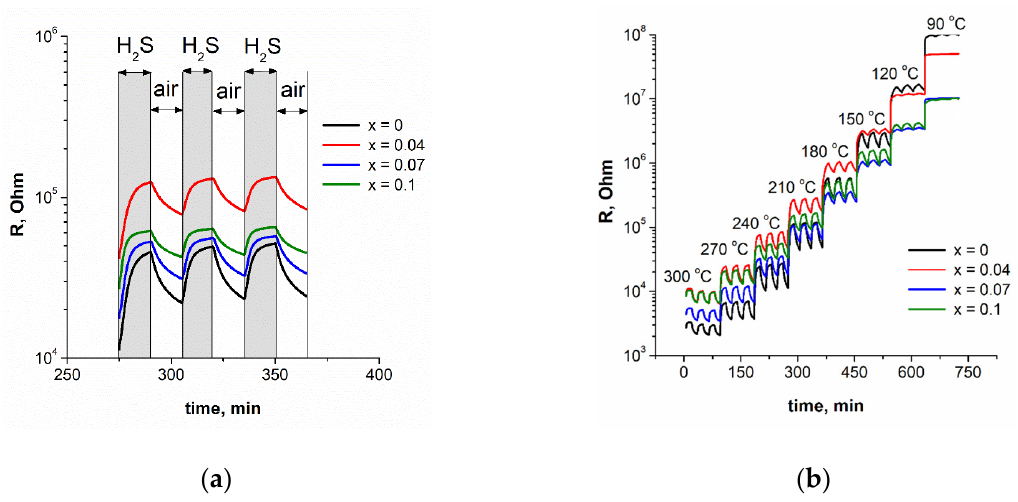
Figure 5. Dynamic response of Co 3 O 4 and Ni x Co 3 − x O 4 based gas sensors in the periodic presence of H 2 S (1 ppm): ( a ) in dry air at 210 °C; ( b ) in humid air (60% R.H.) at 90–300 °C.